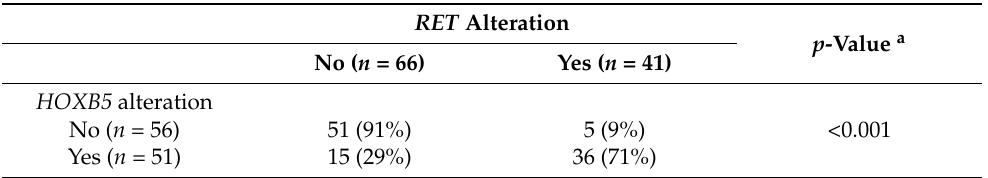
Table 3. Relationship between HOXB5 and RET gene status in copy number alterations in the 107 metastatic prostate cancers in the study by Beltran et al.